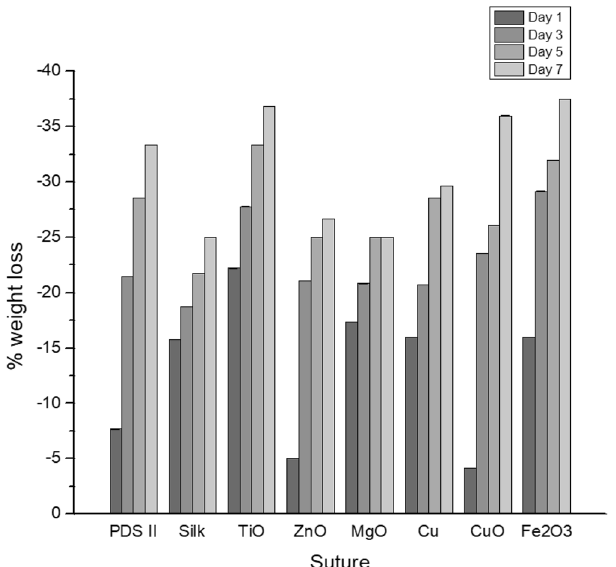
Figure 3. In vitro degradation behavior represented by % weight loss at each timepoint (1, 3, 5, 7 days) after exposure to protease XIV (n = 3). ANOVA and Tukey tests were performed to compare weight differences in coated sutures to weight differences in the uncoated PDS-II samples.